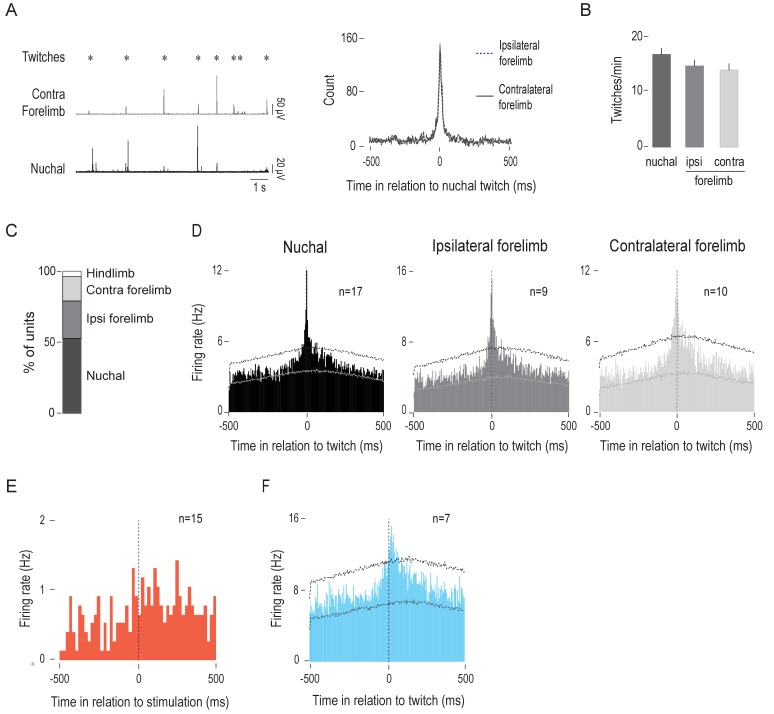
IO units respond predominantly to nuchal and forelimb twitches.(A) Left: Representative recordings of nuchal and contralateral forelimb EMG activity to show the temporal relations among twitches in those muscles. Asterisks denote experimenter-scored twitches. Right: Cross-correlogram (5-ms bins) of nuchal muscle twitches with ipsilateral (dotted line) and contralateral (solid line) forelimb twitches. (B) Mean (+SEM) twitching per min for nuchal muscle and ipsilateral (ipsi) and contralateral (contra) forelimb muscles across 15 P8 rats. Ipsi: ipsilateral; contra: contralateral. (C) Stacked plot showing the percentage of IO units that exhibited significant activity within ±10 ms of twitch onset in relation to nuchal, ipsilateral forelimb, contralateral forelimb, and hindlimb twitches. (D) Perievent histograms (5-ms bins) showing IO unit activity in relation to nuchal, ipsilateral forelimb, and contralateral forelimb twitches. Data are pooled across 17, 9, and 10 units, respectively. Upper and lower confidence bands (p < 0.01 for each band) are indicated by horizontal dashed lines. (E) Perievent histogram (20-ms bins) showing IO unit activity in relation to peripheral limb stimulation for units that were most active within ±10 ms of twitch onset. Data are pooled across 15 units and triggered on 369 stimulations (F) Perievent histogram (5-ms bins) showing twitch-related IO unit activity for units that were most active >10 ms after twitch onset. Data are pooled across 7 units and triggered on 2059 twitches. Upper and lower confidence bands (p < 0.01 for each band) are indicated by horizontal dashed lines.10.7554/eLife.38213.006Figure 2—figure supplement 1—source data 1.Source data for panels A-F.